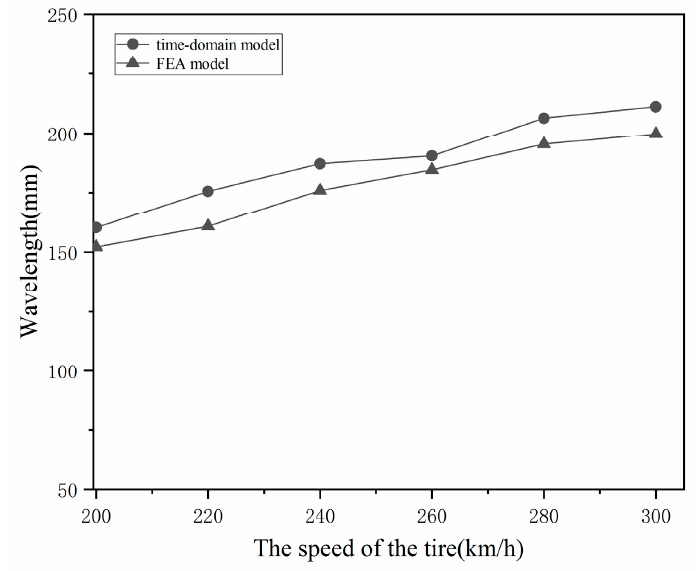
Figure 11. Comparison between time-domain model and FEA model results on wavelength of standing waves.